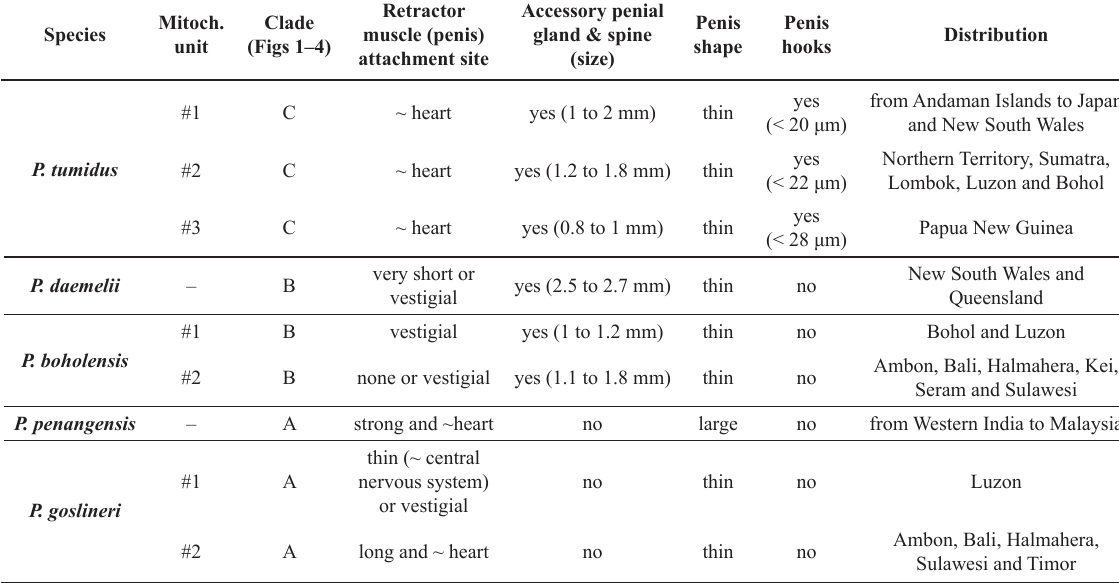
Table 3. Summary of internal traits that can help distinguish species of Paromoionchis gen. nov. All traits may be subject to individual variation. Traits are described in detail in the corresponding species descriptions and discussed in the species remarks. Traits are indicated for the mitochondrial units (when applicable) to show that those units are cryptic